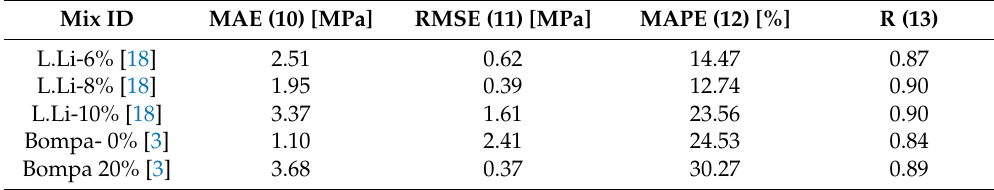
Table 9. Statistical performance of Constitutive models for validation samples.